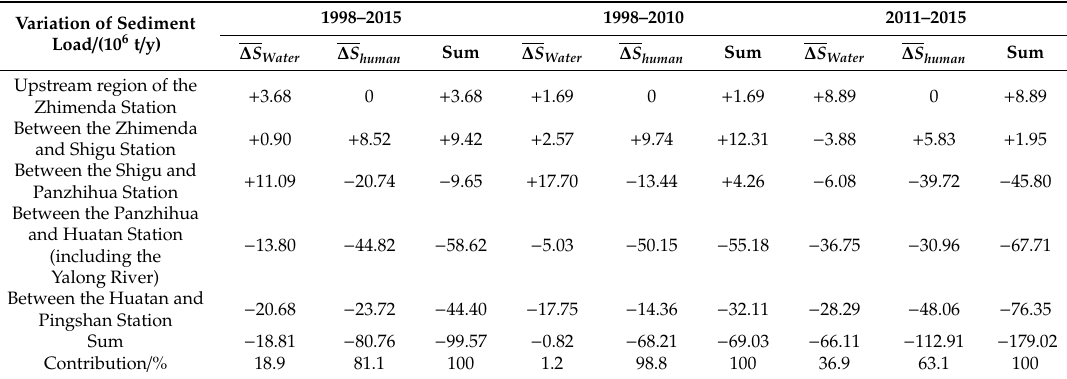
Table 6. Estimations of the variation of sediment load caused by water discharge and human